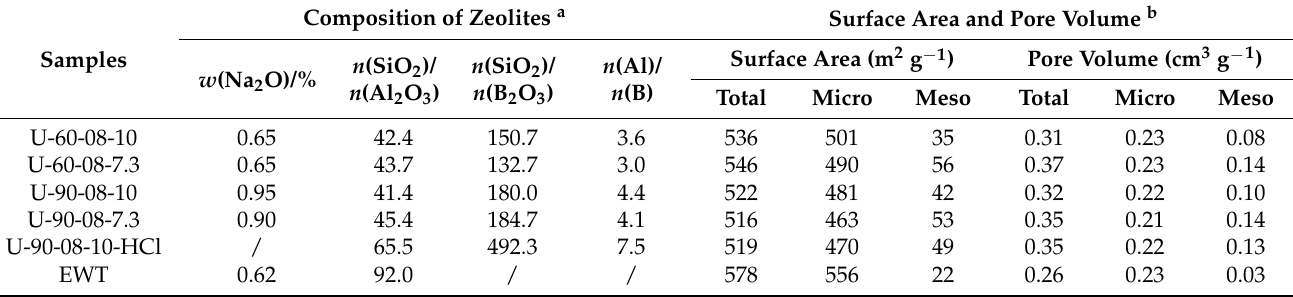
Table 2. The feed ratio and elemental composition of samples.